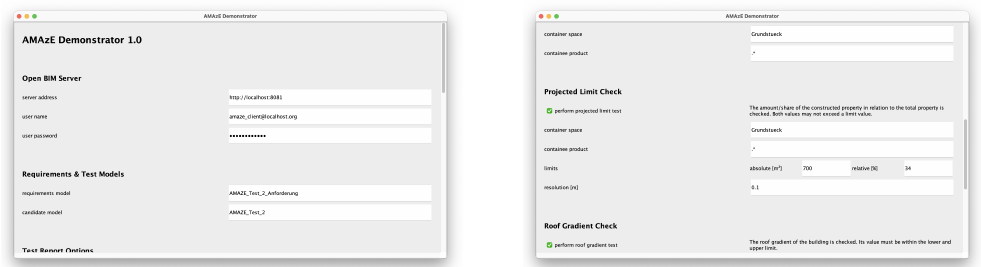
Figure 10. The application provides a form to access the BIM server and to specify the requirements and the candidate models ( left ). Furthermore, it comprehends the possibility to configure each test individually by setting the corresponding test parameters ( right